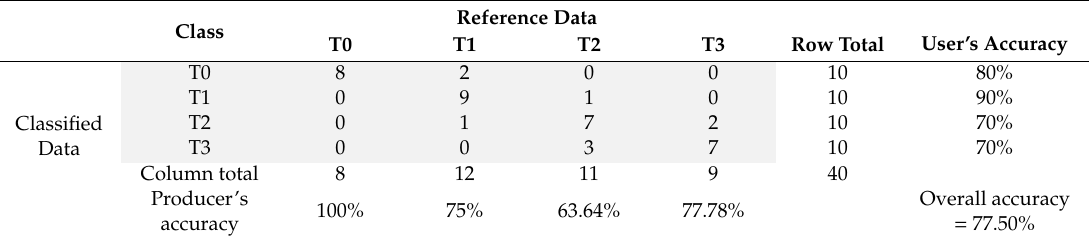
Table 9. Confusion matrix of medium Gaussian support vector machine (MGS; input of PC1 and PC3).